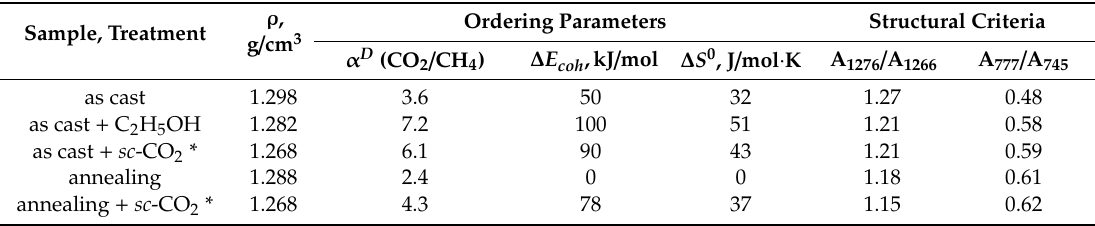
Table 3. Quantitative characteristics of packing ordering for Ultem films and for various treatment methods based on the analysis of di ff usion coe ffi cients and structural criteria of Ultem samples prepared under equivalent